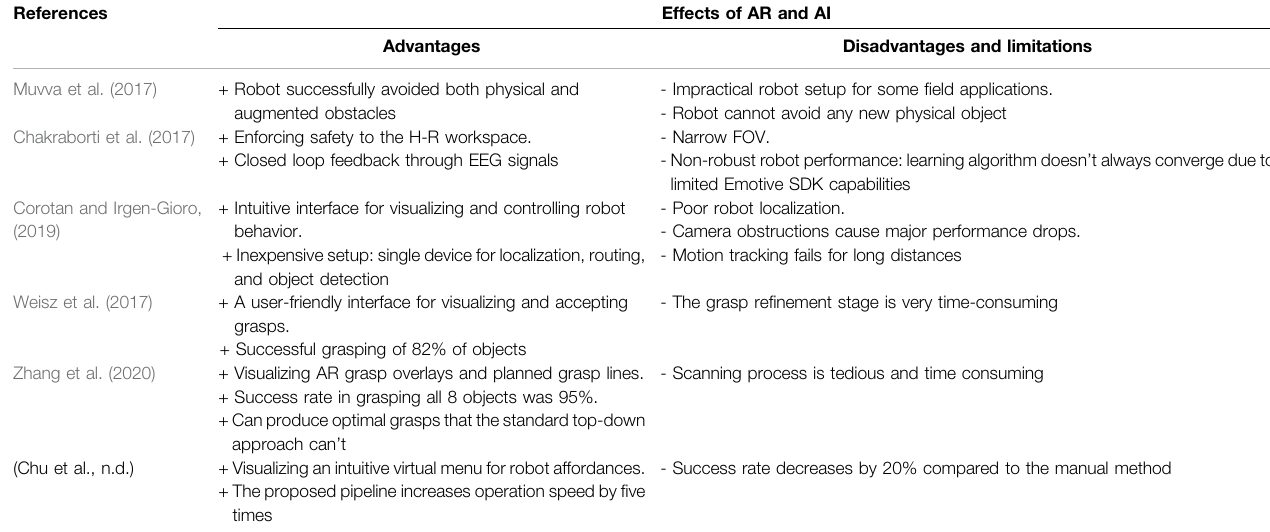
TABLE 4 | The advantages as well as the disadvantages and limitations of each method in the Planning